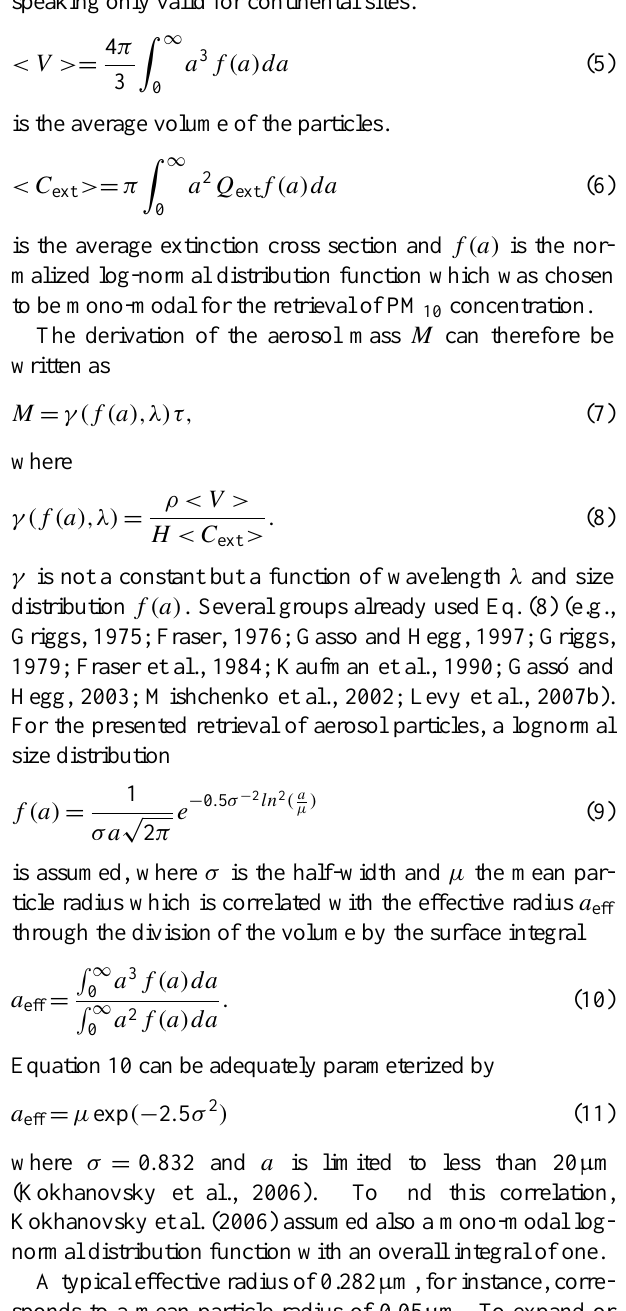
Fig. A5. Correlation between ˚Angstr¨om- α coefficient and effective radius as derived from Mie calculations and interpolated data from O PAC of water soluble particles.